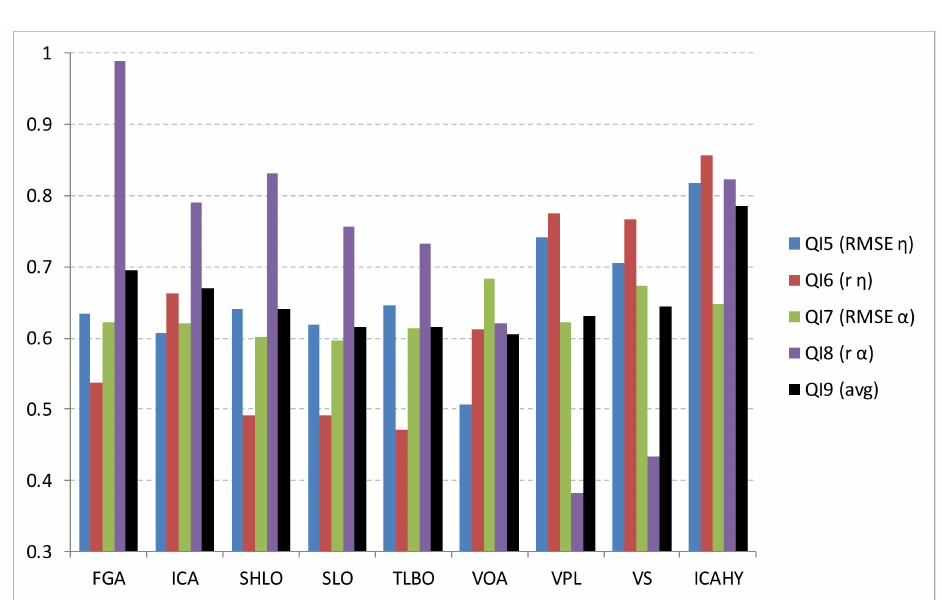
Figure 11. A comparison of the results obtained for the training and testing